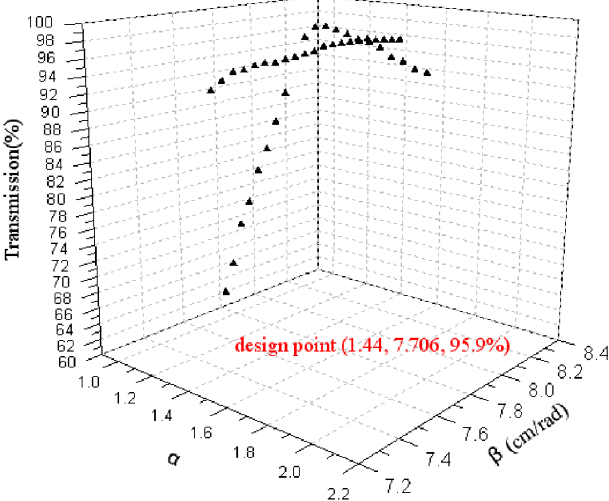
FIG. 16. Emittance of the output beam as a function of the phase width.